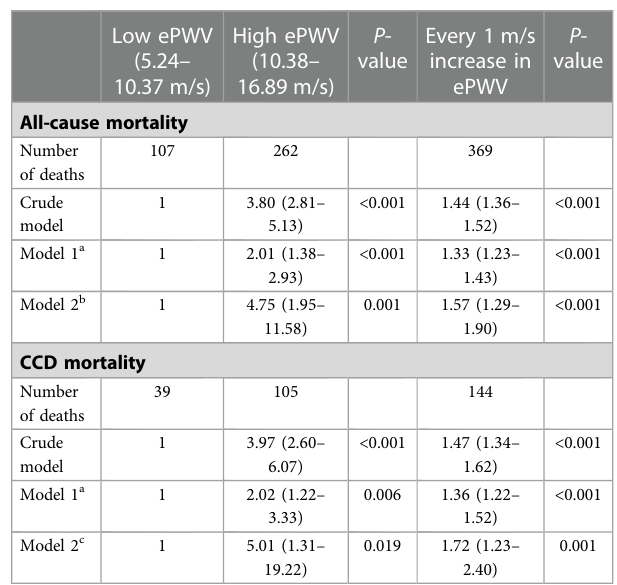
TABLE 2 Weighted univariate and multivariate Cox regression to assess the association between ePWV levels and the risk of all-cause and cardiovascular disease mortality in stroke